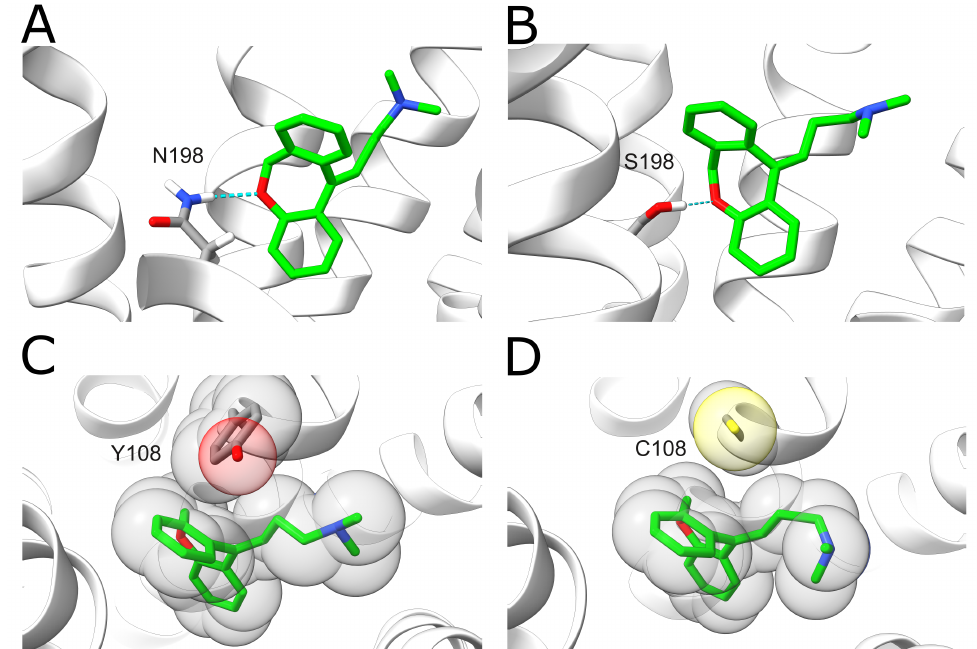
Figure 7. Effect of H 1 R sequence variants N198S and Y108C on doxepin binding. ( A ) A hydrogen bond (blue dotted line) is formed between N198 5.461 and doxepin. N198 5.461 and doxepin are shown in stick representation and colored according to the type of element (carbons of N198 5.461 and doxepin are colored in gray and green, respectively). ( B ) In the N198S variant, a weaker hydrogen bond (thin dotted line) is formed due to the shorter serine sidechain. ( C ) Interaction between Y108 3.33 and doxepin. The interaction partners are shown in stick representation, and the volume of the atoms is additionally indicated as transparent spheres. ( D ) The smaller sidechain of the Y108C variant results in a loss of hydrophobic interactions with